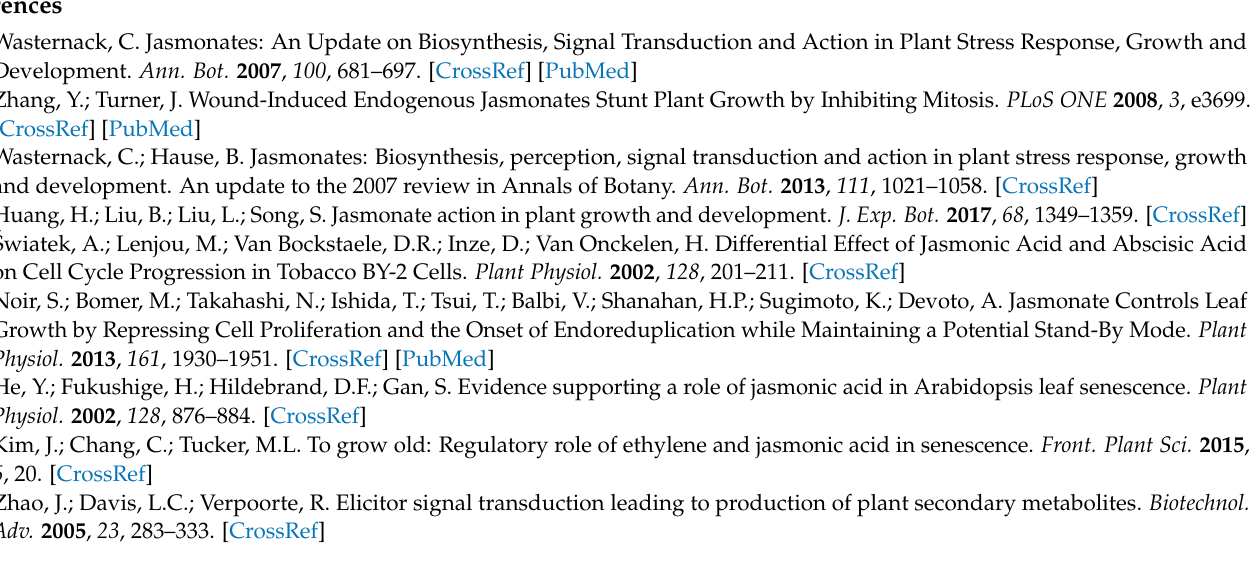
Table S5. MYC2 genes in pineapple; Table S6. JAM1 genes in pineapple; Table S7. NINJA genes in pineapple; Table S8. BiFC identification of protein–protein interactions among central regulators of the JA-signaling pathway in pineapple; Supplemental File S1. All protein sequences used for phylogenetic analysis in this study; Supplemental File S2. The motif information of pineapple JAZ